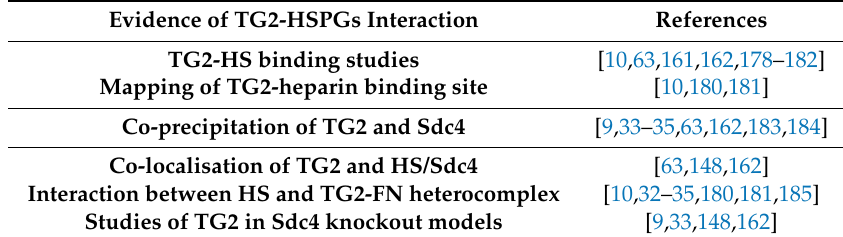
Table 1. Interactions between transglutaminase-2 and heparan sulfate proteoglycans. TG2, transglutaminase- 2; HS, heparan sulfate; HSPGs, heparan sulfate proteoglycans; Sdc4, syndecan-4; FN,